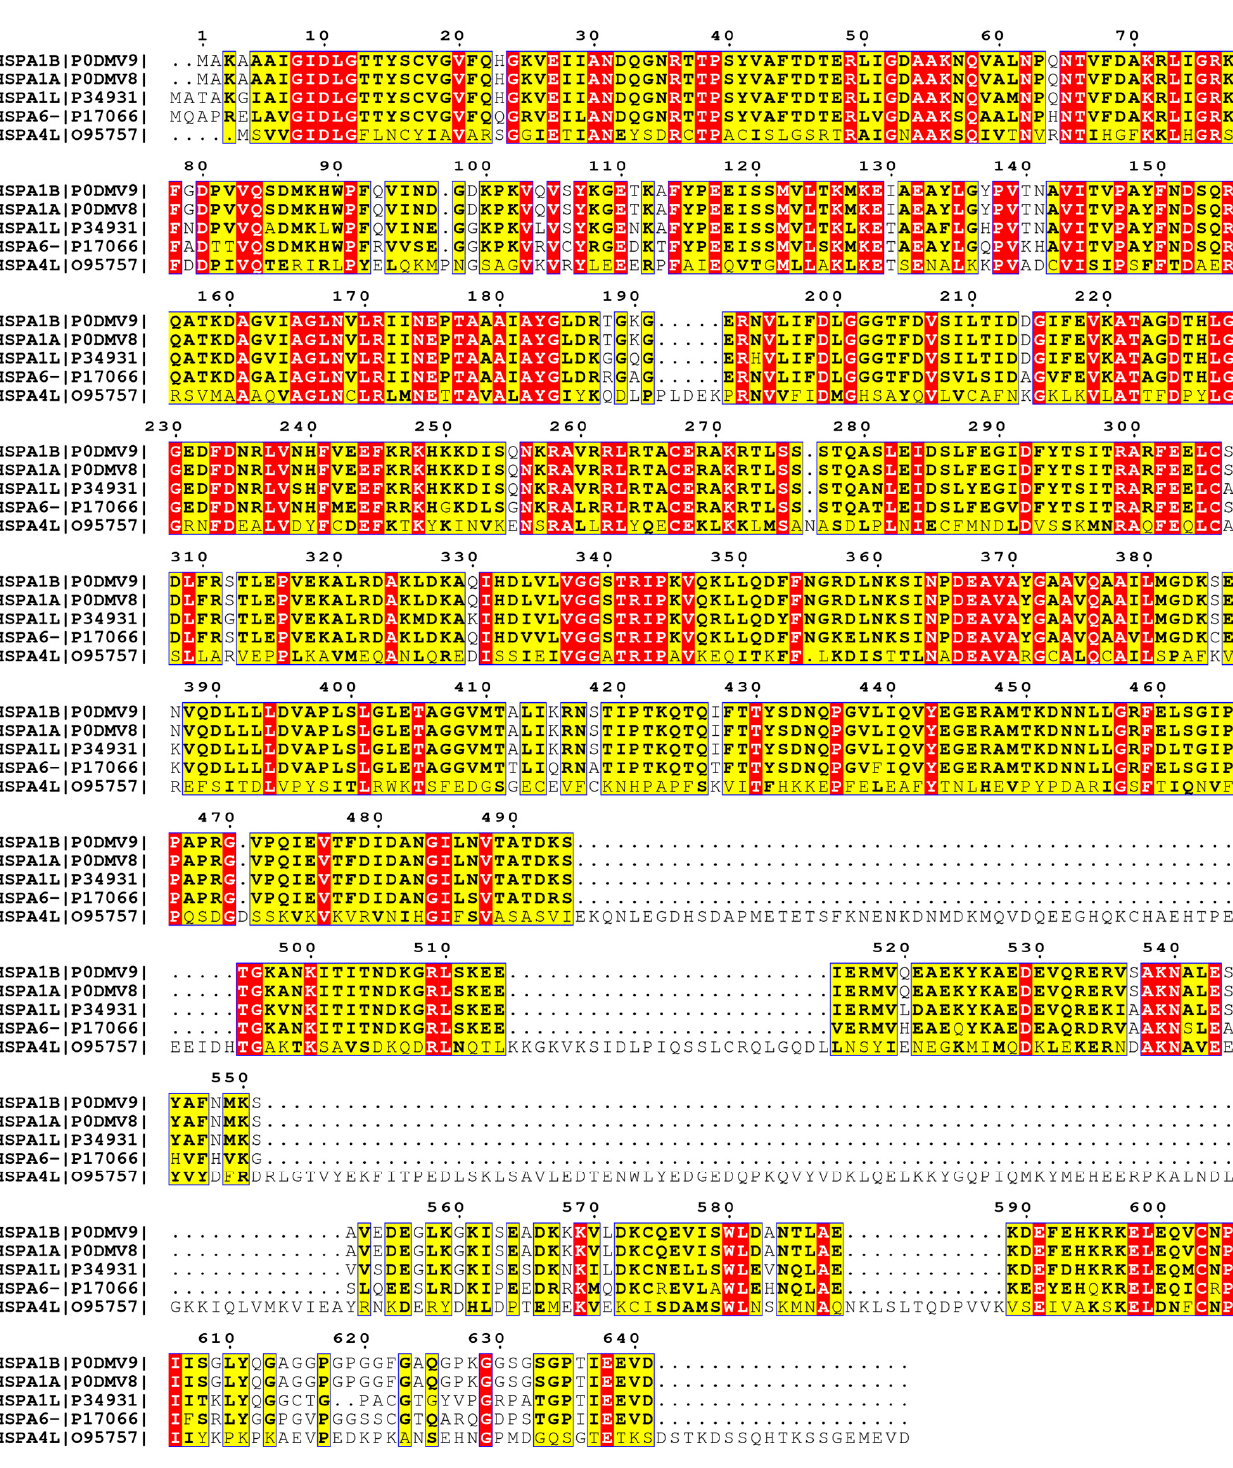
Figure 10. Multiple Sequence Alignment (MSA) of Hsp70 overexpressed members HSPA1B, HSPA1A, HSPA1B, HSPA1L, HSPA6 and HSPA4L. The red regions highlight the high-identity regions. The sequences are the UniProt sequences, with Uniprot IDs listed alongside the label (see Figure S5. MSA for highly homologous HSPA1A, HSPA1B, HSPA4L, and